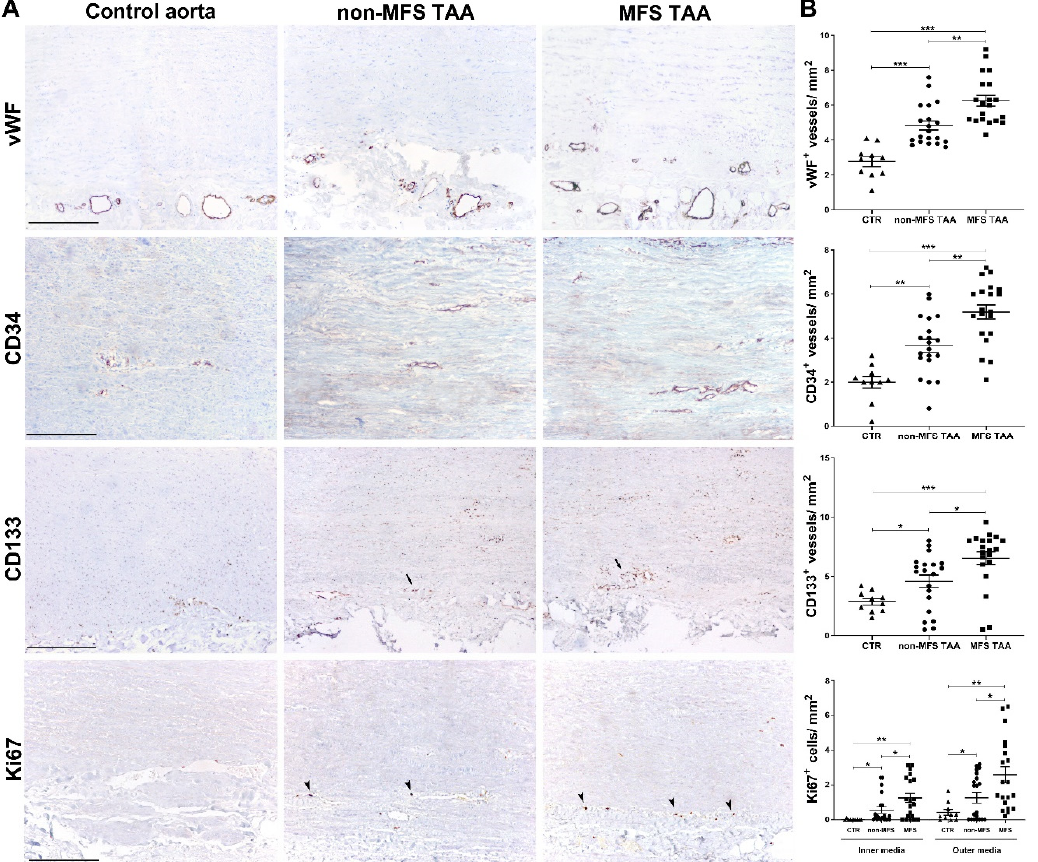
Figure 3. Increased angiogenesis and vascular precursor cell recruitment characterize MFS thoracic aortic aneurysm. ( A ) Representative images of vWF, CD34, CD133 and Ki67 immunostainings in the tunica media of MFS and non-MFS TAA and control aorta. Perivascular CD133 + cells are indicated by arrows, whereas Ki67 + nuclei are represented by arrowheads. Scale bars are equal to 150 µ m. ( B ) Semiquantitative evaluations of immunoreactivity show increased vWF, CD34 + and CD133 + neovessels, as well as a higher number of Ki67 + cells/ mm 2 mostly in the outer media of MFS TAA compared with non-MFS and control aorta. MFS TAA ( n = 20), non-MFS TAA ( n = 20) and control aorta ( n = 10). Averages are reported as means ± SEM; * p < 0.05; ** p < 0.01; *** p < 0.001; estimated by t -test. Abbreviations: AU, arbitrary units.